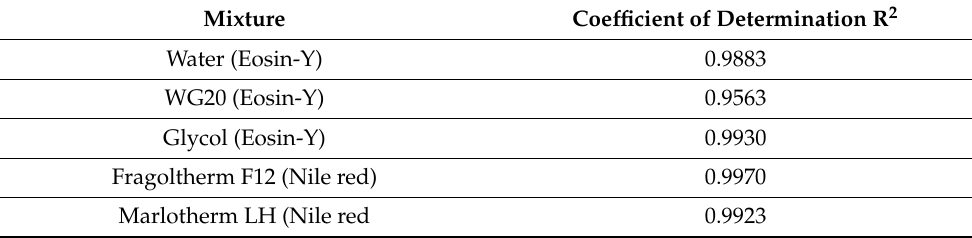
Table 3. Coefficients of determination R 2 for concentration-dependent emission measurements.